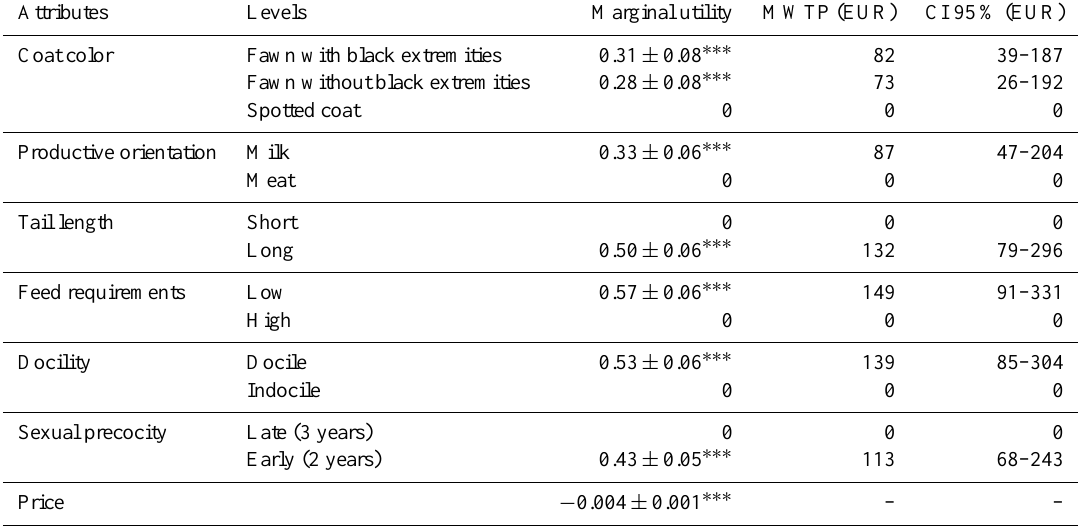
Table 3. Utility coefficients and willingness to pay estimated for Azawak sire traits in